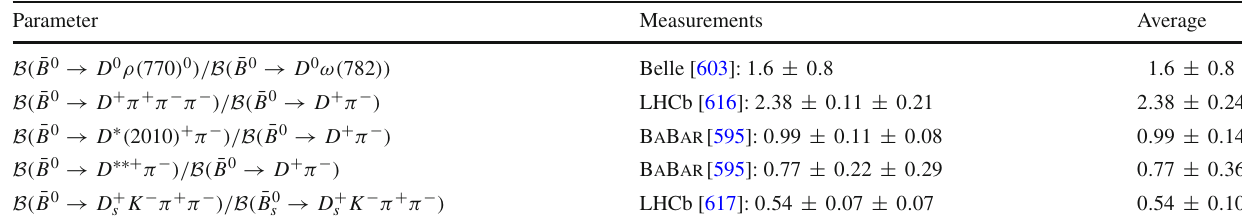
Table 99 Relative decay rates I